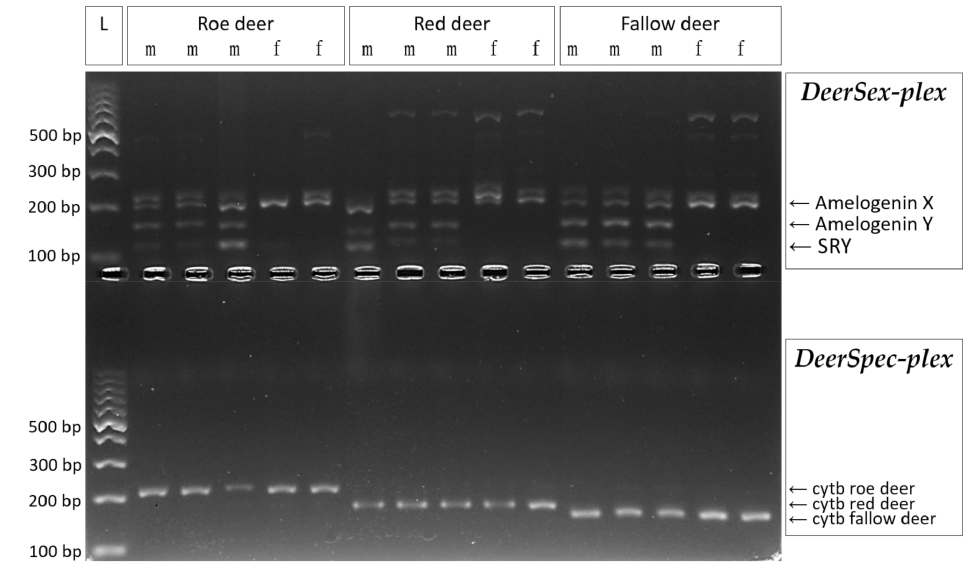
Figure 1. Multiplex PCR amplification for three cervid species. DeerSex-plex panel contains Amel- ogenin markers (194 bp for X and 140/149 bp for Y allele) and SRY (113 bp), the males show three specific bands and females show a single specific band in the agarose gel. DeerSpec-plex panel contains species-specific cytochrome b markers for roe deer (218 bp), red deer (176 bp) and fallow deer (162 bp) and show a single species specific band on agarose gel. L: ladder, m: male sample, f: female